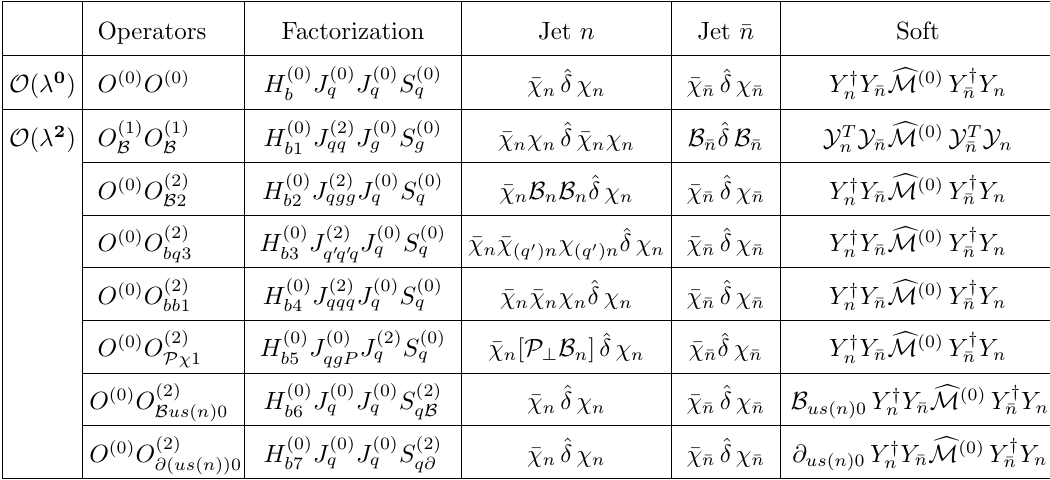
Table 3 . Beam and soft functions up to ( (cid:21) 2 ) arising from products of hard scattering operators O in the factorization of Higgs with a jet veto, and their (cid:12)eld content. We have suppressed the helicity and color structures. We have not included products of operators whose beam and soft functions are identical to those shown by charge conjugation or n (cid:22) n $